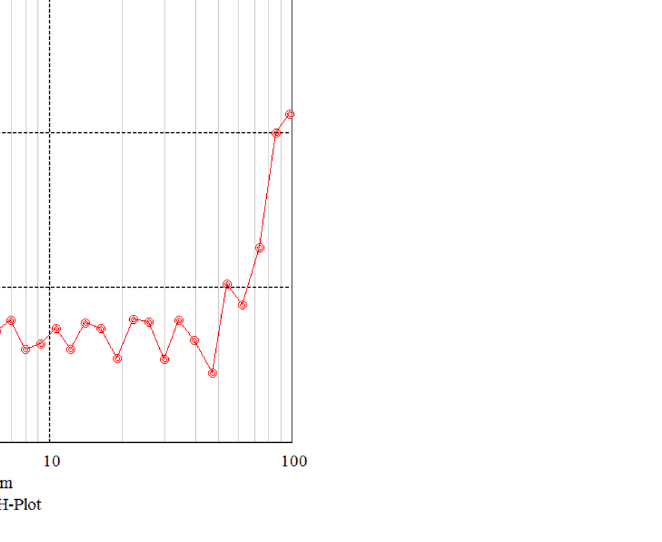
Figure 9. BJH pore size distribution for